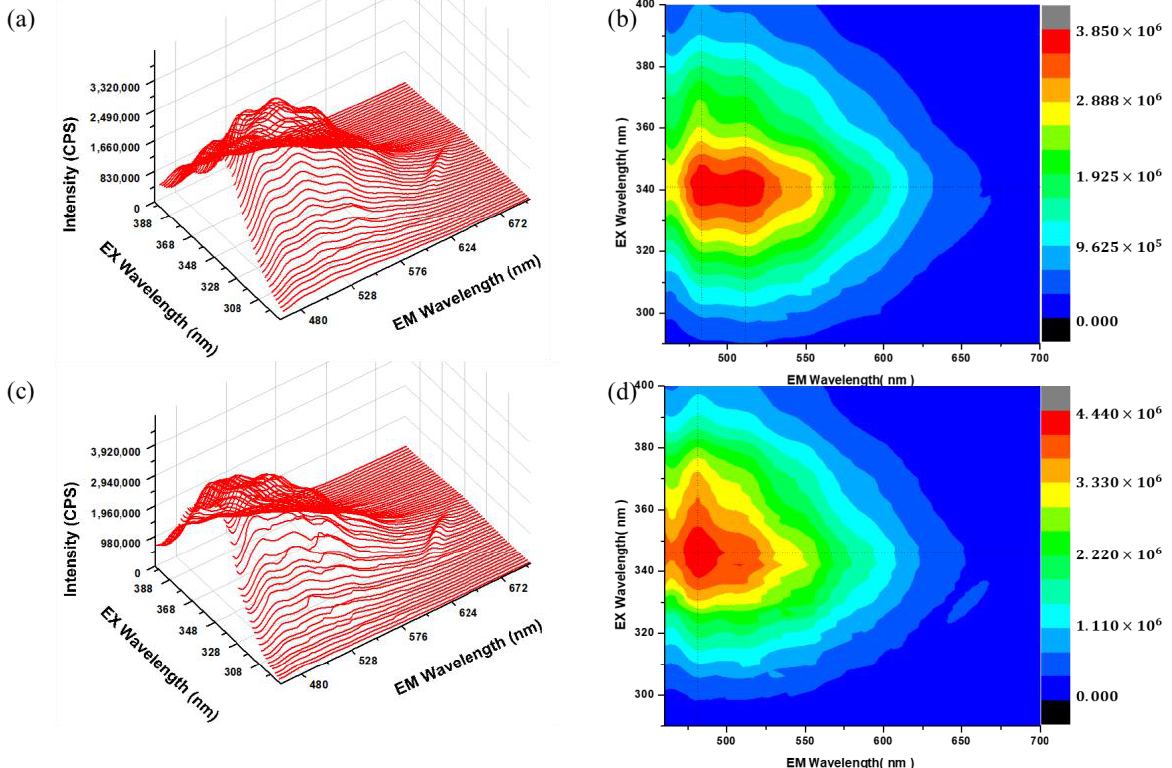
Figure 6. Three-dimensional (3D)-PL spectra of ( a ) undoped ZnS nanopowder, ( b ) Ti-doped ZnS nanopowder 3D) PL/PLE map, ( c ) 3D-PL spectra of Ti-doped ZnS nanopowder, ( d ) Ti-doped ZnS nanopowder 3D PL/PLE map.